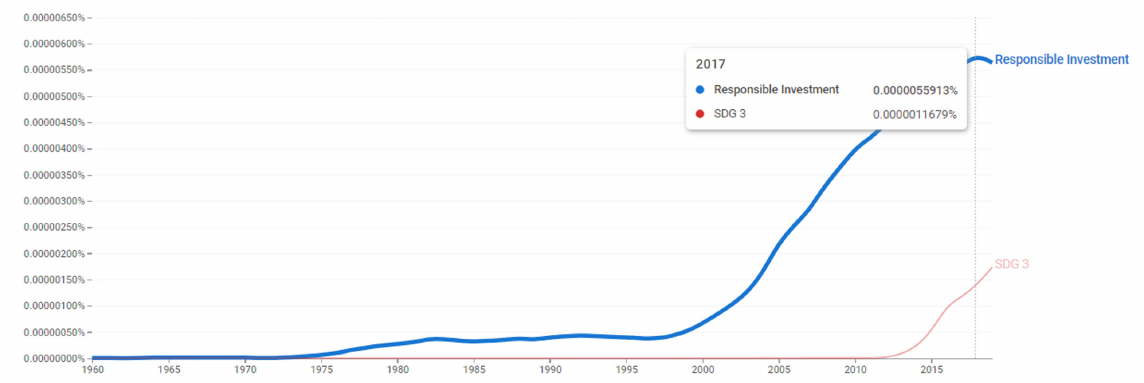
Figure 7. Ngram concerning “SDG 3 and responsible investment” in